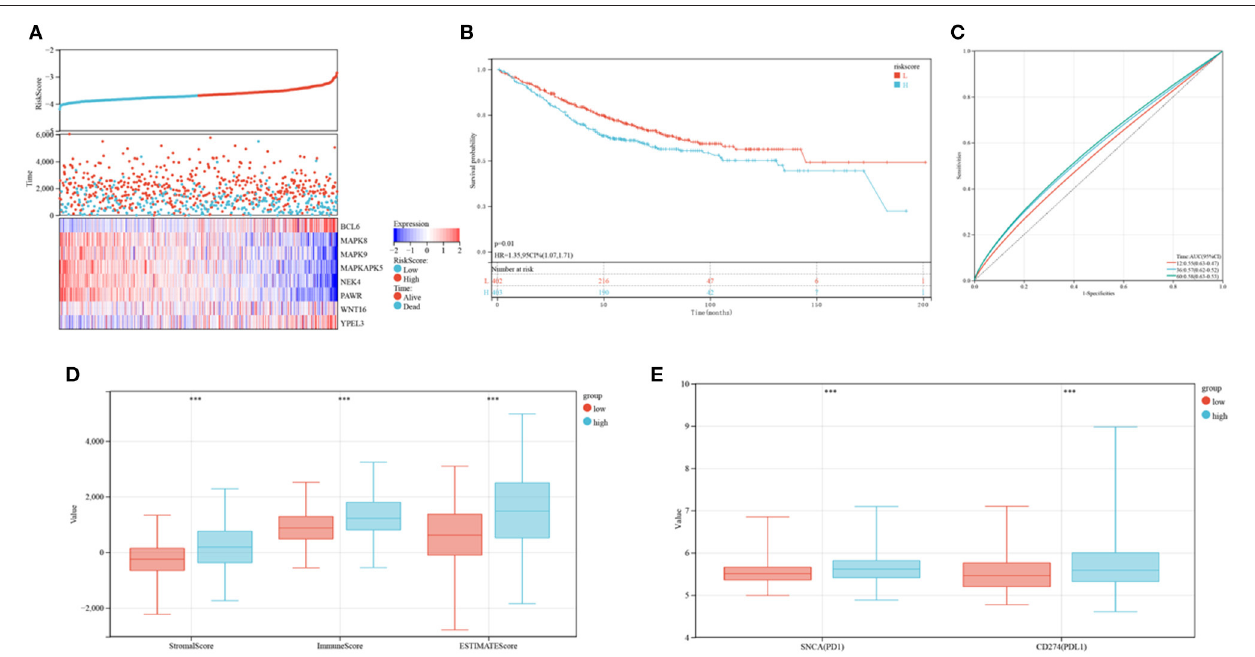
FIGURE 10 | Verification of the established risk mode in GEO cohorts. (A) Distribution of risk scores and survival status of CRC patients as a function of SRG expression. (B) Kaplan-Meier analysis of OS in the low and high-risk groups. (C) ROC plots predicting the specificity and sensitivity of 1, 3, and 5-year survival in the low and high-risk groups. (D) Comparison of stromal, immune and ESTIMATE scores in the low and high-risk groups. (E) Expression of immune checkpoints in the low and high-risk